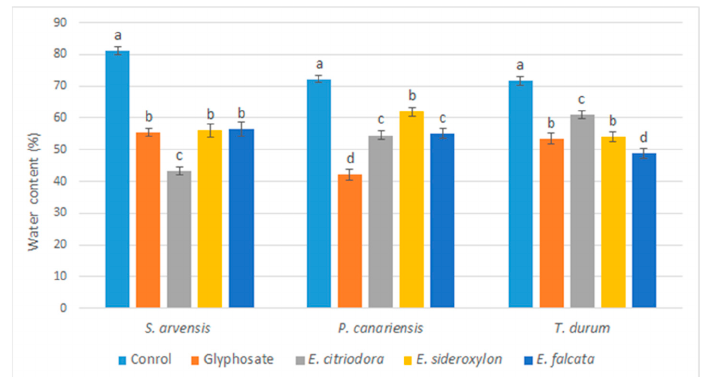
Figure 5. Effects of Eucalyptus essential oils and glyphosate on water content % of test plants measured five days after application. Error bars and letters on graphs represent standard error means and significant differences at p ≤ 0.05 through Student–Newman–Keuls.